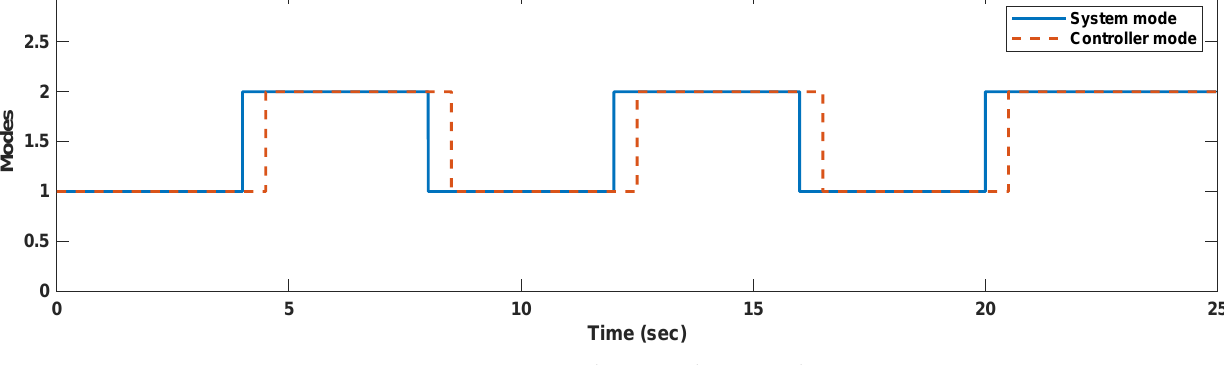
Figure 13. Example 3: Switching signal.